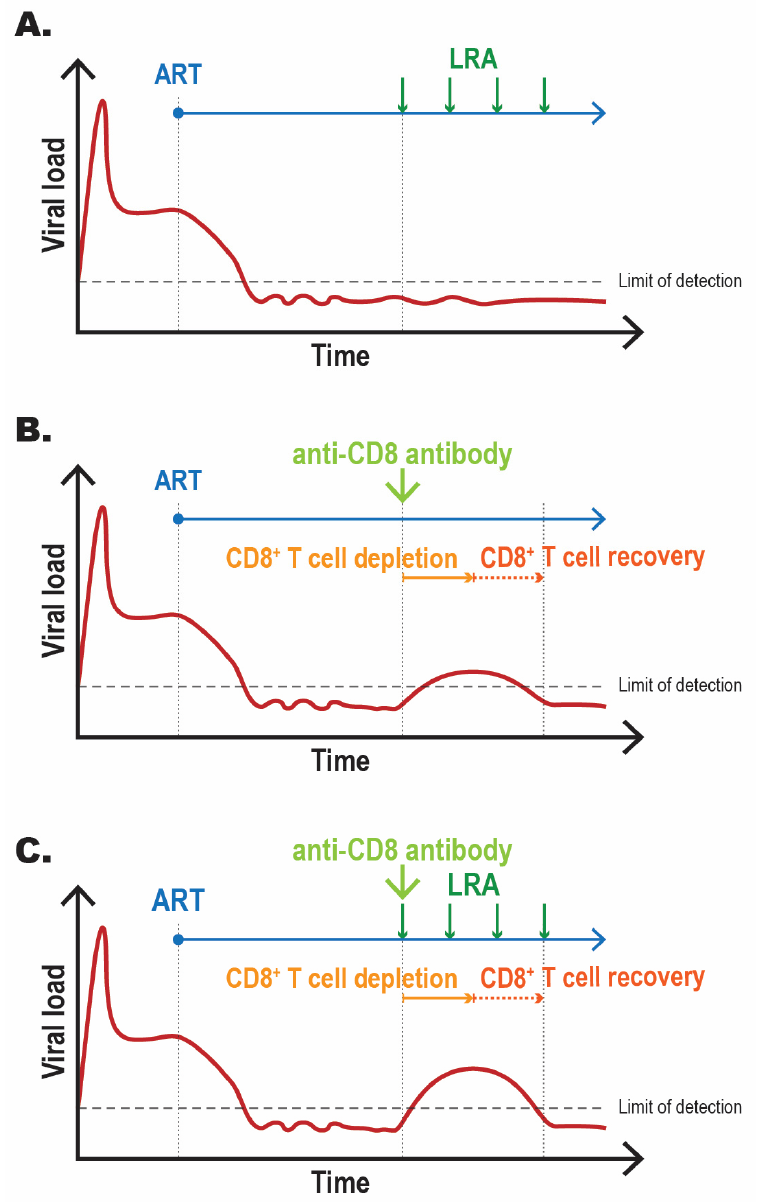
Figure 2. Viral dynamics following LRA administration and/or CD8 + T cell depletion in ART- treated SIV-infected rhesus macaques. The three graphs summarize the impact of ( A ) LRA admin- istration, ( B ) CD8 + T cell depletion, or ( C ) combined CD8 + T cell depletion and LRA